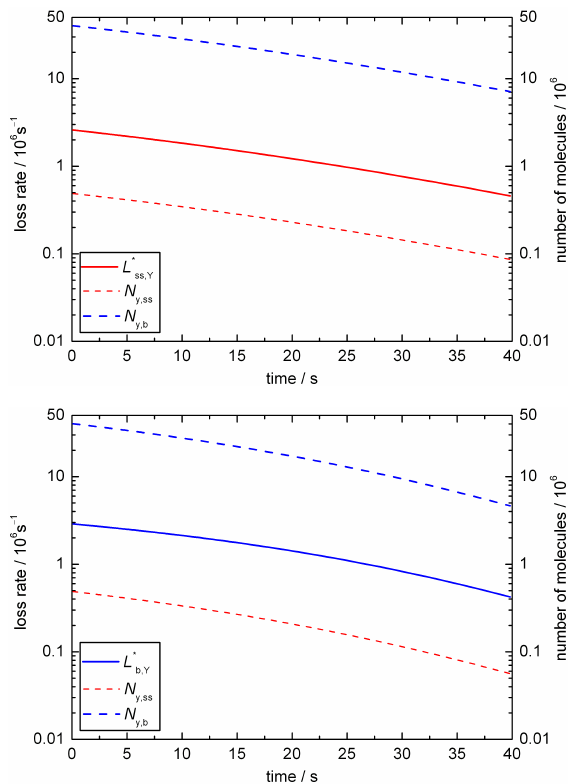
Fig. 9. Temporal evolution of aerosol particle composition and ki- netic parameters in sensitivity studies for BC2 with chemical reac- tion occurring (a) only at the surface or (b) only in the bulk. Plots are analogous to Fig.